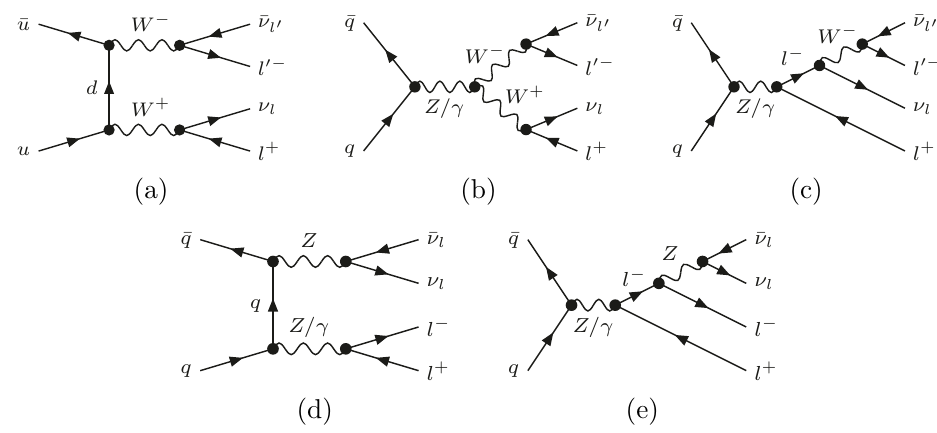
Figure 1 . Born-level Feynman diagrams for W + W (cid:0) production: (a-c) contribute to both the DF channel ( ‘ 6 = ‘ 0 ) and the SF channel ( ‘ = ‘ 0 ); (d-e) only contribute in the SF